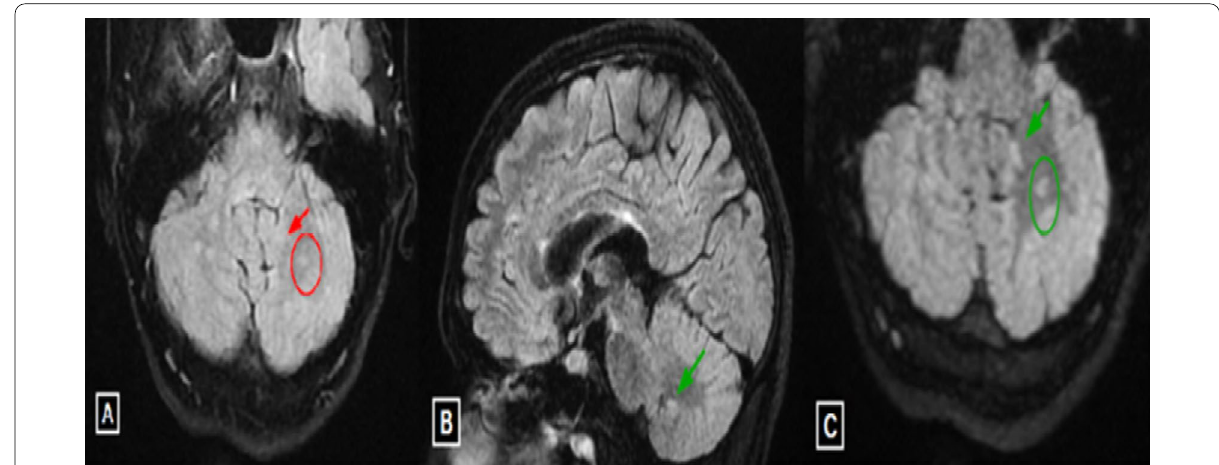
Fig. 1 Infra-tentorial sections: the 3D FLAIR and axial MIP (green arrows at B and C ) show a well delineated left cerebellar MS lesion that is not seen in 2D FLAIR (red arrow at A ). A poorly seen lesion (encircled in red at A ) is clearly demonstrated in axial MIP (encircled in green at C ). Also, the sharp demarcation of the layers of the cerebellum is noted